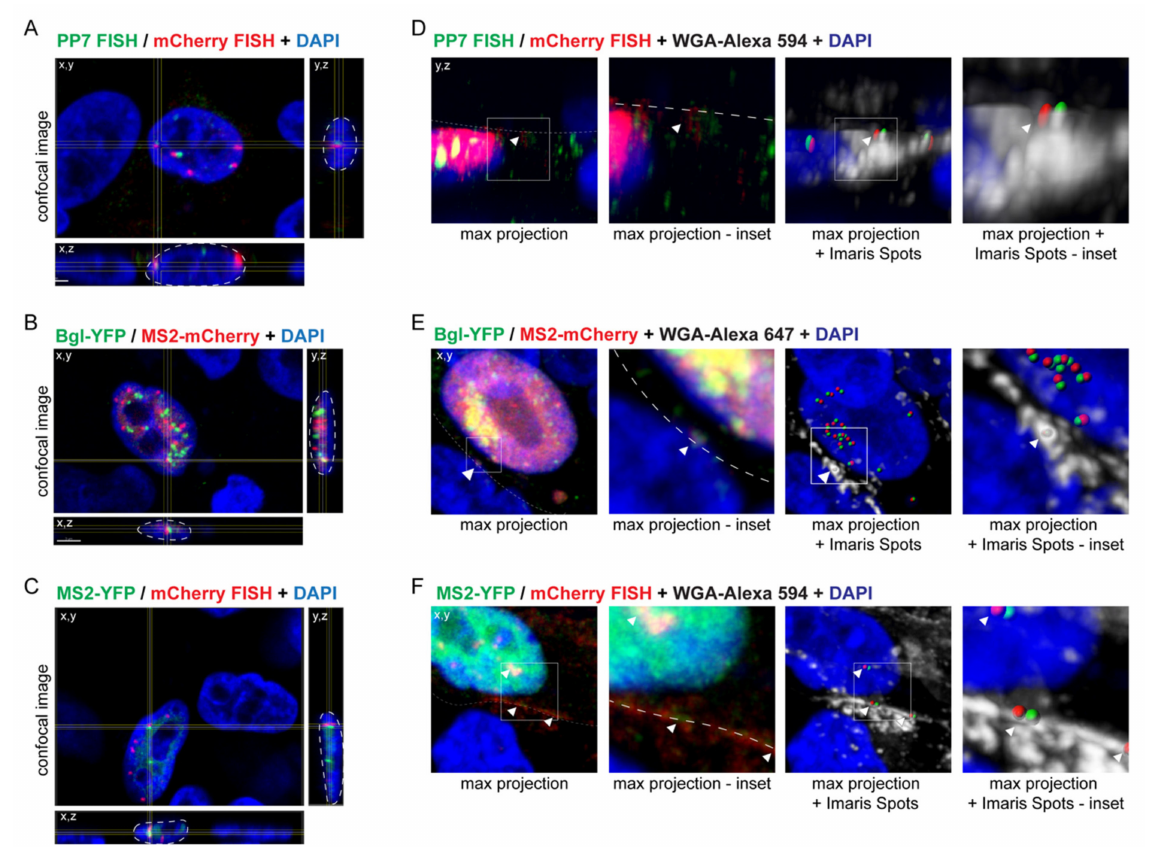
Figure 2. Examples of genome heterodimers located in the nucleus and at the plasma membrane. Shown are representative images of genome heterodimers within the nucleus ( A – C ), as defined by DAPI staining (blue), and at the plasma membrane, as defined by WGA-Alexa 594 staining ( D , E ) or Alexa 647 staining ( F ) in gray, for each of the described imaging methods. See Materials and Methods for further detail on the selection of the appropriate WGA conjugate. For the images showing genome heterodimers within the nucleus, the crosshairs expand into x,z and y,z planes to show the genome heterodimer is located within the DAPI staining in three dimensions (as outlined in white dashed line). For the images showing genome heterodimers at the plasma membrane, the two images on the left are a max projection image and inset showing the genome heterodimer at the plasma membrane (outline in white dashed line), while the two images on the right show the WGA-Alexa 594 or WGA-Alexa 647 staining (in gray) with Imaris Spots representing genome heterodimers. White arrowheads mark representative genome heterodimers at the plasma membrane ( D , E ) and at the plasma membrane and in the nucleus ( F ). Image histograms were adjusted in the Imaris software for ease of visualization for the purpose of this manuscript. Images were obtained using a 63 × objective at a 3.5 × optical